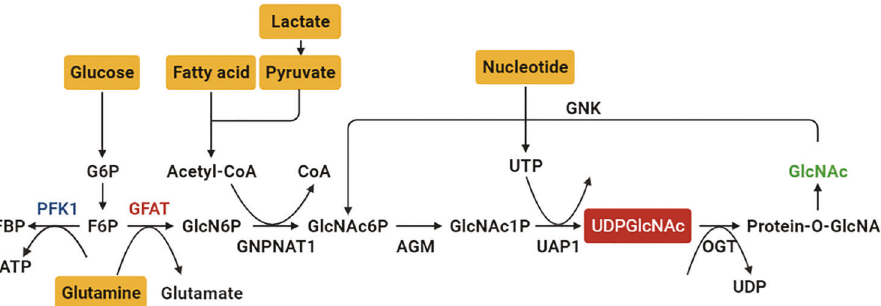
Fig. 2 The de novo hexosamine biosynthetic pathway (HBP) and GlcNAc salvage pathway integrate metabolic status from core metabolism intermediates, including glycolysis, fatty acid, amino acid and nucleotide metabolism, to generate uridine diphosphate-N- acetylglucosamine (UDP-GlcNAc). Approximately 2 – 5% of cellular glucose enters the HBP to generate the end product UDP-GlcNAc. Glutamine:fructose-6-phosphate amidotransferase (GFAT) is the rate-limiting enzyme for the HBP. O -GlcNAc transferase (OGT) adds UDP- GlcNAc to target protein serine and threonine residues, and O -GlcNAcase (OGA) removes O -GlcNAc from O-GlcNAcylated proteins. The balance between the enzyme activities of phosphofructokinase (PFK) and GFAT through regulating GFAT may be crucial to direct the pathways. G6P glucose 6-phosphate, F6P fructose 6-phosphate, FBP fructose 1,6-phosphate, GlcN6P glucosamine-6-phosphate, GlcNAc6P N- acetylglucosamine-6-phosphate, GlcNAc1P N-acetylglucosamine-1-phosphate, GAT acetyl-CoA:D-glucosamine-6-phosphate N-acetyltransfer- ase, AGM phosphor-N-acetylglucosamine mutase, AGX1 UDP-GlcNAc pyrophosphorylase, GNK GlcNAc kinase. The graph was created with